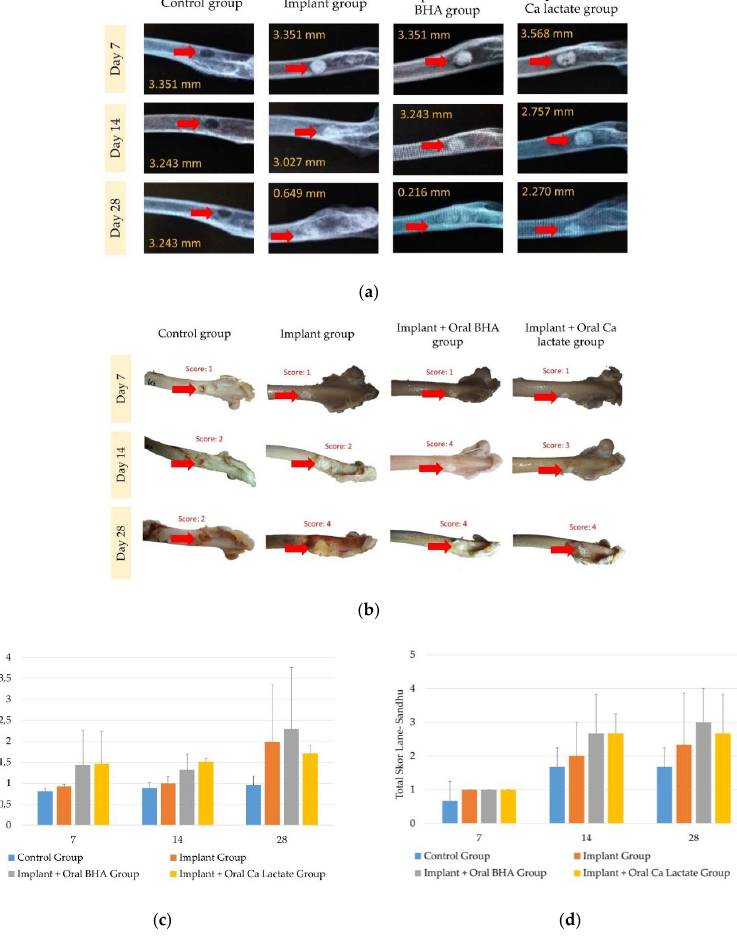
Figure 2. ( a ) X-Ray radiology results of rabbit femur (1024 × 1024 pixel); ( b ) rabbit femur bone macroscopic; ( c ) result of measurement of bone cleft closure; ( d ) calculation results with Lane – Sandhu Scoring. The red arrow in subfigures ( a , b ) indicates the location of the defect. The implanted group showed accelerated bone growth in the defect area. 3.3. Examination of the number of Osteoblasts, Osteoclasts and Osteocytes through Hematoxylin-Eosin Staining The data from the observation of osteoblast cells (Figure 3a) obtained showed that the data were normally distributed ( p > 0.05) and homogeneous ( p > 0.05) for each termi- nation period. On days 7 and 28, there was no significant difference (one-way ANOVA; p